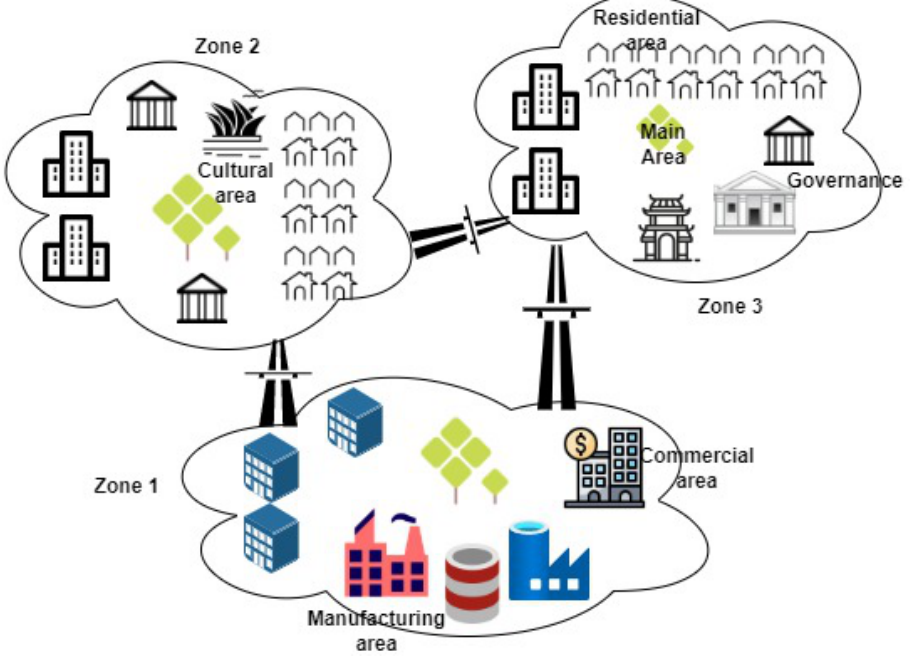
Figure 1. Zoning framework for a new smart